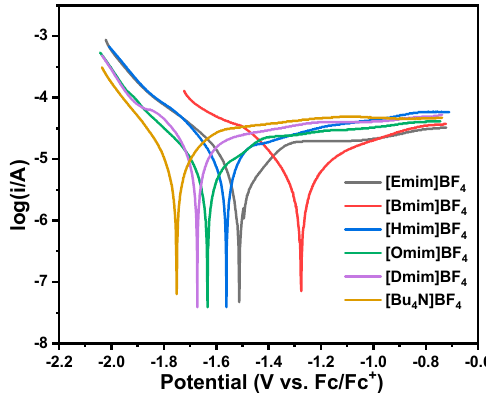
Figure 3. Tafel plots of CO 2 reduction in CO 2 -saturated PC solution of ILs and [Bu 4 N]BF 4 . Table 1. Electrochemical kinetic parameters of CO 2 reduction in [Emim]BF 4 /PC, [Bmim]BF 4 /PC,